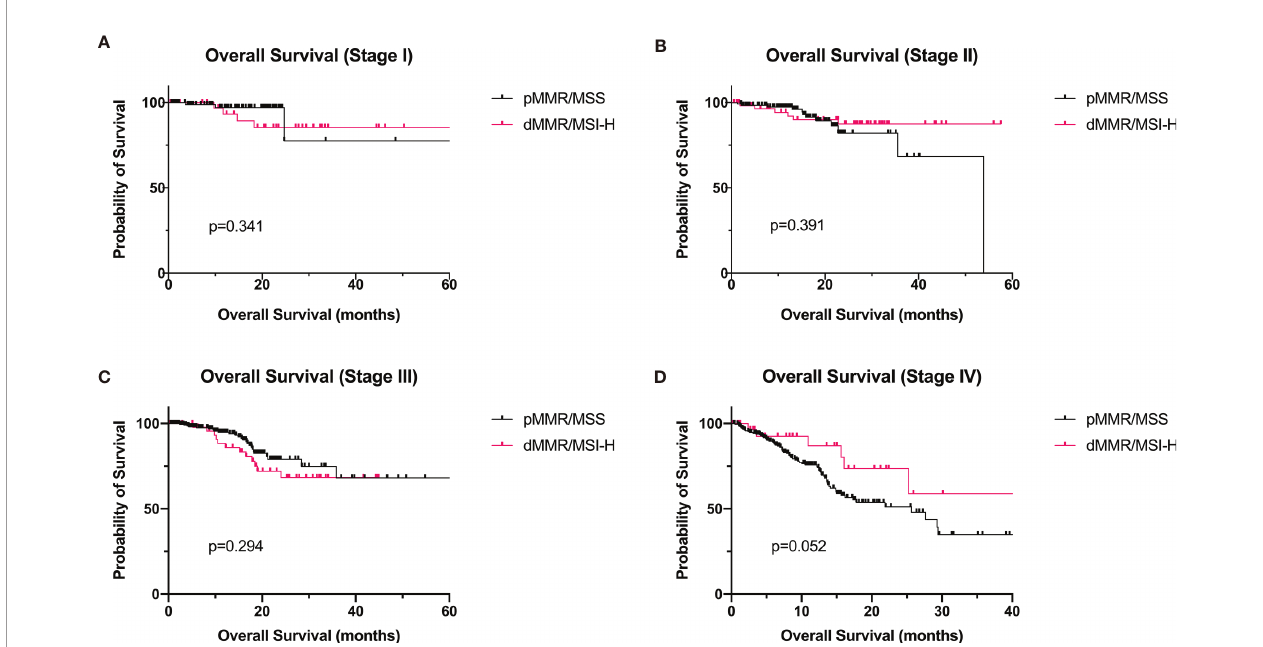
FIGURE 2 | Overall survival of GC patients with dMMR/MSI-H and pMMR at stages I – IV. (A) Stage I (dMMR/MSI-H: n = 40; pMMR: n = 89). (B) Stage II (dMMR/ MSI-H: n = 59; pMMR: n = 130). (C) Stage III (dMMR/MSI-H: n = 51; pMMR: n = 235). (D) Stage IV (dMMR/MSI-H: n = 32; pMMR: n = 240). GC, gastric cancer; dMMR, de fi cient DNA mismatch repair; MSI-H, microsatellite instability-high; pMMR, pro fi cient mismatch